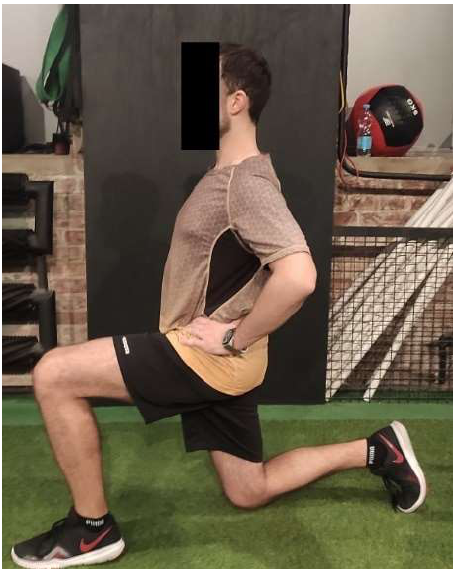
Figure A4. Lunge.